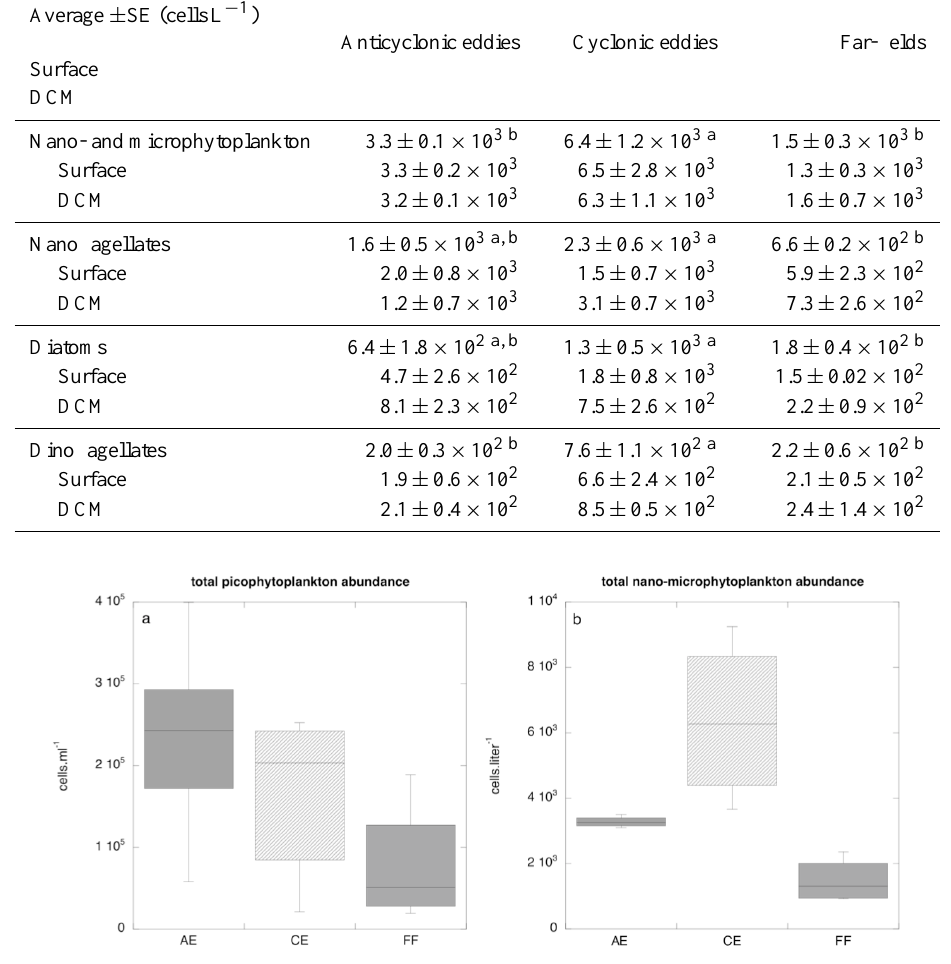
Fig. 6. Distribution of the total pico- (a) and nano- and microphytoplankton (b) within AE, CE and FF stations. Boxes show the lower and upper quartiles, median, minimum and maximum